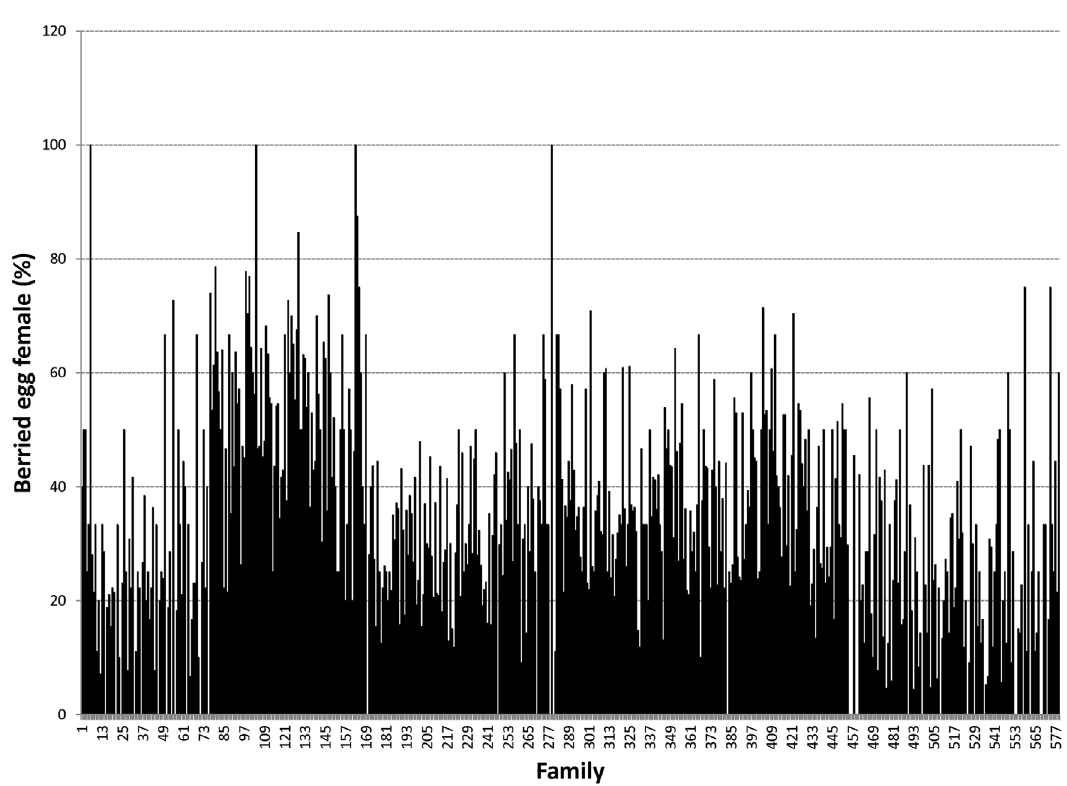
Figure 7. Berried egg female.